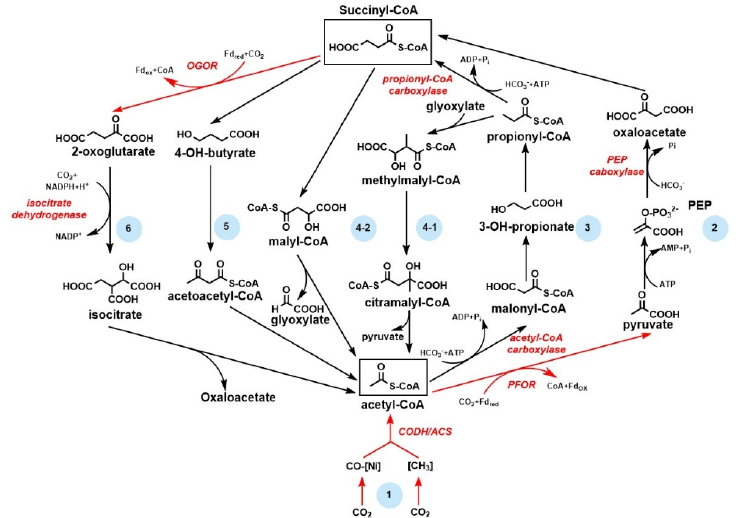
Figure 2. Schematic illustration of the other five carbon dioxide fixation pathways. The involved carbon dioxide fixation enzymes are indicated in red italics and oxygen-sensitive carbon fixation reactions are shown in red arrow. Routine numbers are enclosed in light blue circles. The reductive acetyl-CoA (rAC) pathway is composed of Routine 1 and Routine 2. The reductive tricarboxylic (rTCA) cycle consists of Routine 2 and Routine 6. Routine 2 and Routine 5 represent the anaerobic dicarboxylate/4-hydroxybutyrate (DC/HB) cycle. The aerobic carbon dioxide fixation pathways include the 3-hydroxypropionate (3HP) bi-cycle, which consists of Routine 3, Routine 4–1 and 4–2, and the 3-hydroxypropionate/4-hydroxybutyrate (HP/HB) cycle, which is the combination of Routine 3 and Routine